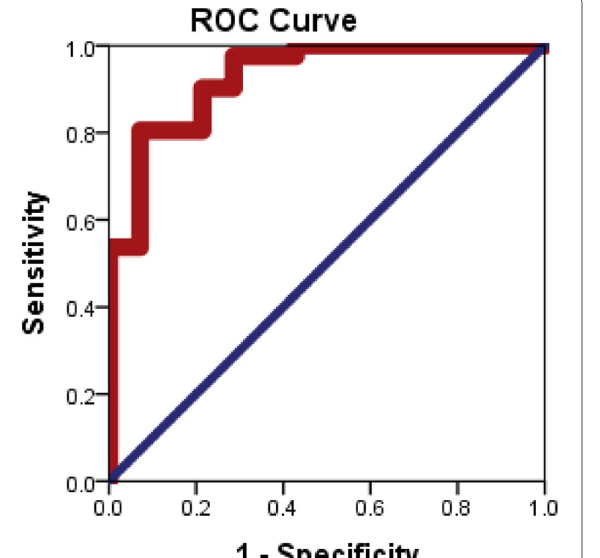
Fig. 4 ROC curve of complement C3 to discriminate NAFLD patients from control subjects